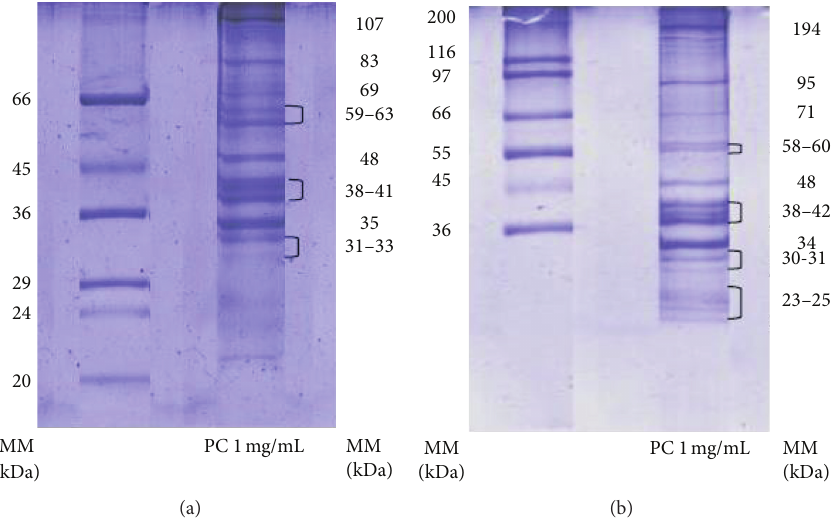
Figure 1: Protein fractions in the concentrate from SDS-PAGE with (a) a low molecular marker and 10% polyacrylamide and (b) a high molecular weight marker and 12% polyacrylamide, stained with Coomassie blue. PC: protein concentrate in a 1mg/mL solution.